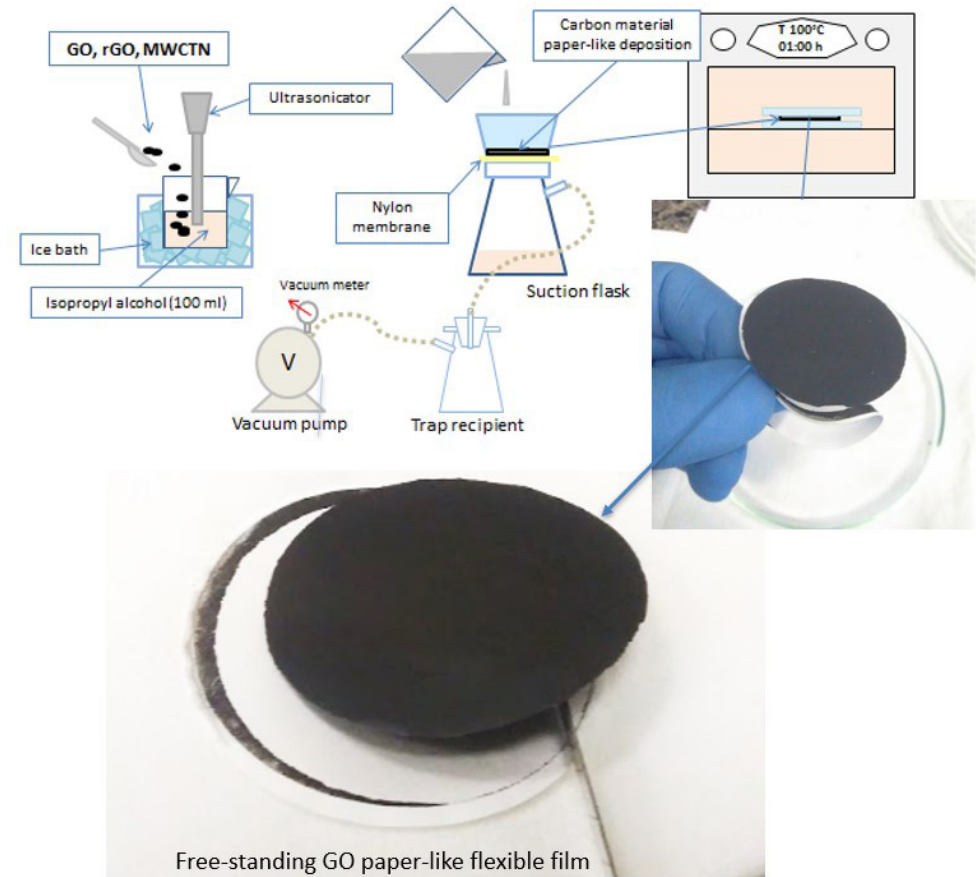
Figure 1. Summarized carbon nanomaterials papers manufacturing